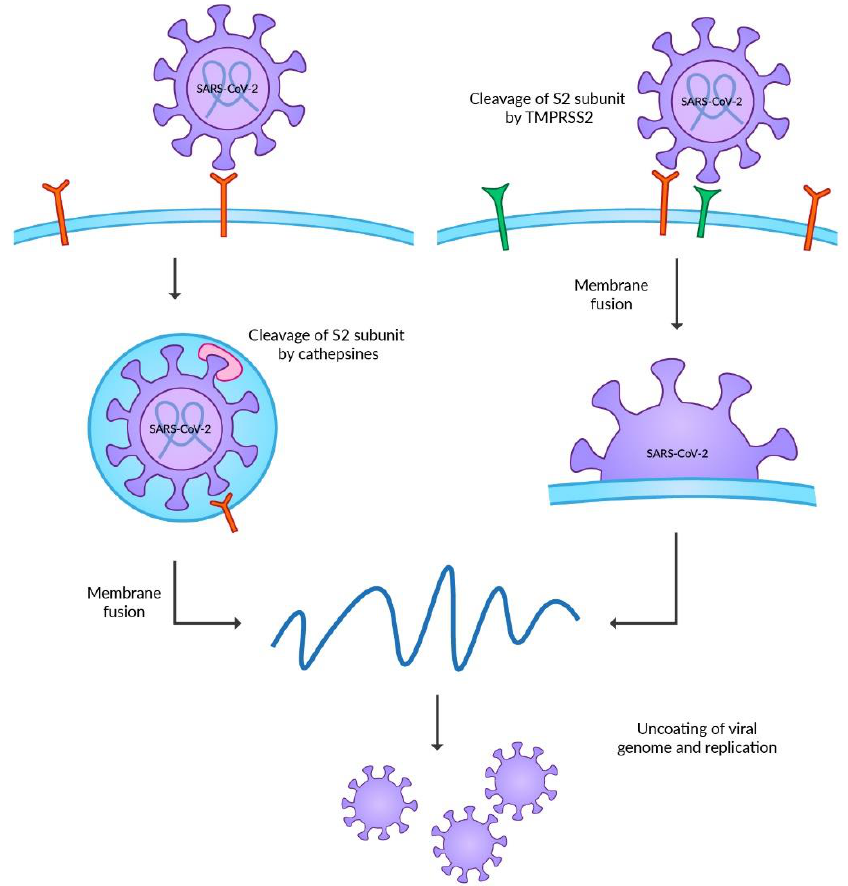
Figure 1. SARS-CoV-2 can enter the host cell via two separate mechanisms. The endosomal entry pathway uses cathepsins to catalyze the modification of the S2 subunit of Spike protein. TMPRSS2 is required in the surface entry mechanisms to cleavage the S2 subunit. Both courses enable membrane fusion and cell invasion.